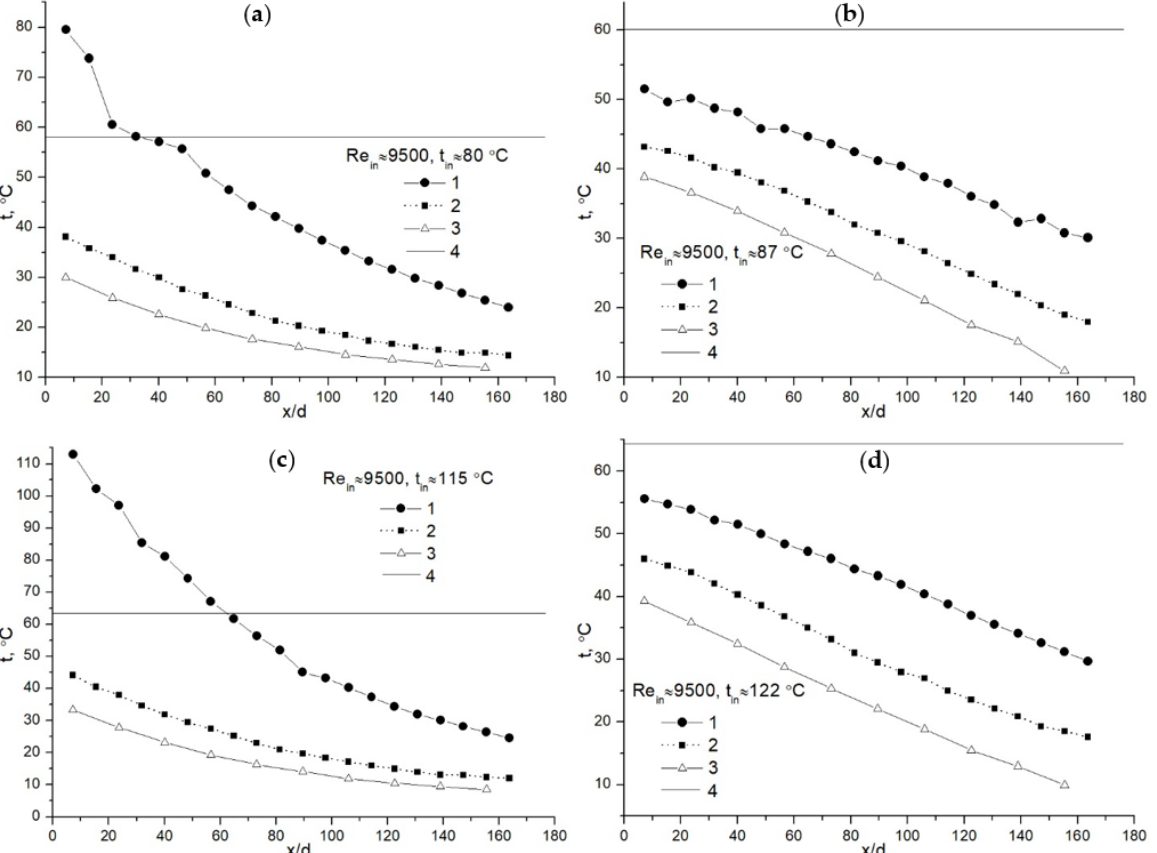
Figure 2. Temperature distribution along the model of the condensing heat exchanger at Re in ≈ 9500, different flue gas inlet temperatures and in the case when water is not injected ( a ) Re in ≈ 9500, t in ≈ 80 °C, ( c ) Re in ≈ 9500, t in ≈ 115 °C and is injected ( b ) Re in ≈ 9500, t in ≈ 87 °C, ( d ) Re in ≈ 9500, t in ≈ 122 °C: (1) center of the calorimetric tube, (2) inner wall of the calorimetric tube, (3) cooling water in the middle of the inner and the outer tubes, (4) dew point temperature at the inlet to the calorimetric tube.